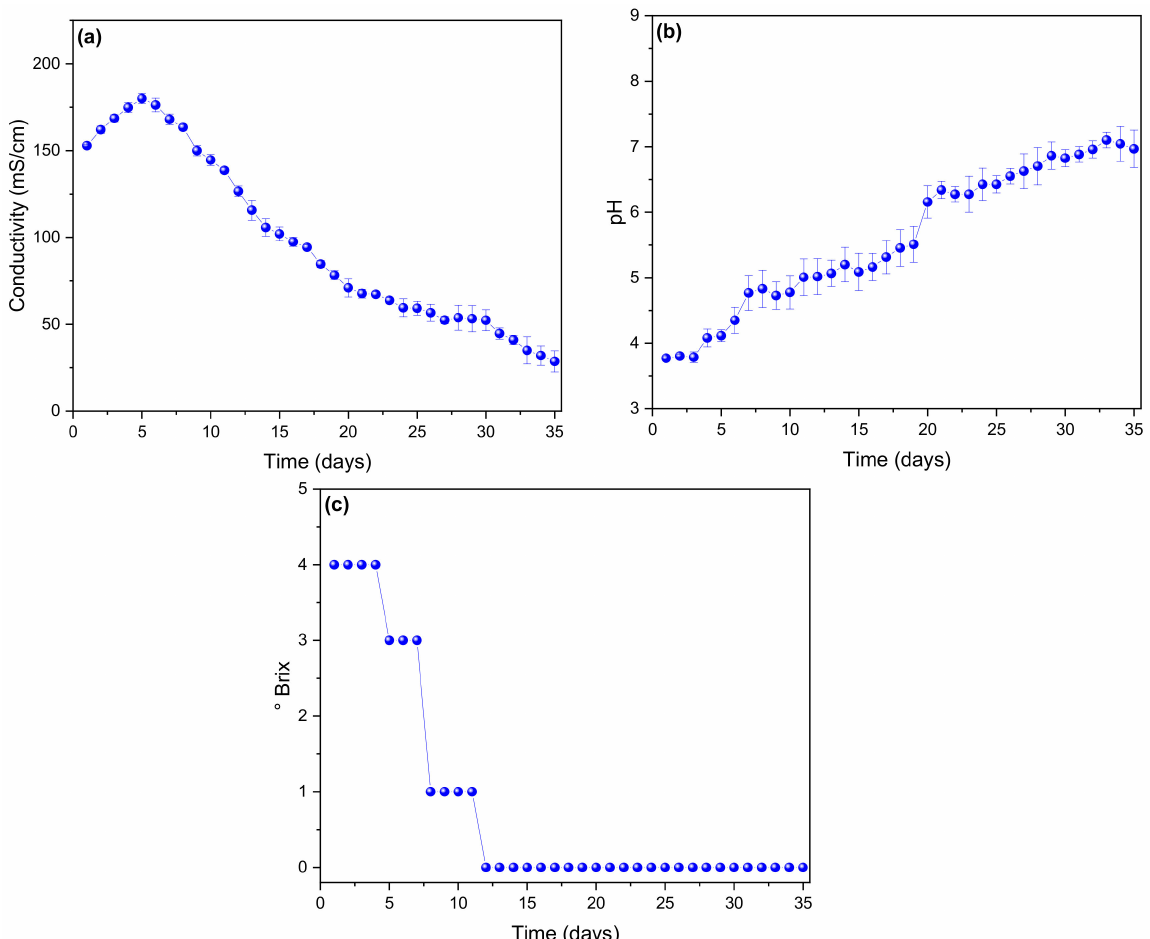
Figure 3. Values of ( a ) conductivity, ( b ) pH, and ( c ) ◦ Brix of the microbial fuel